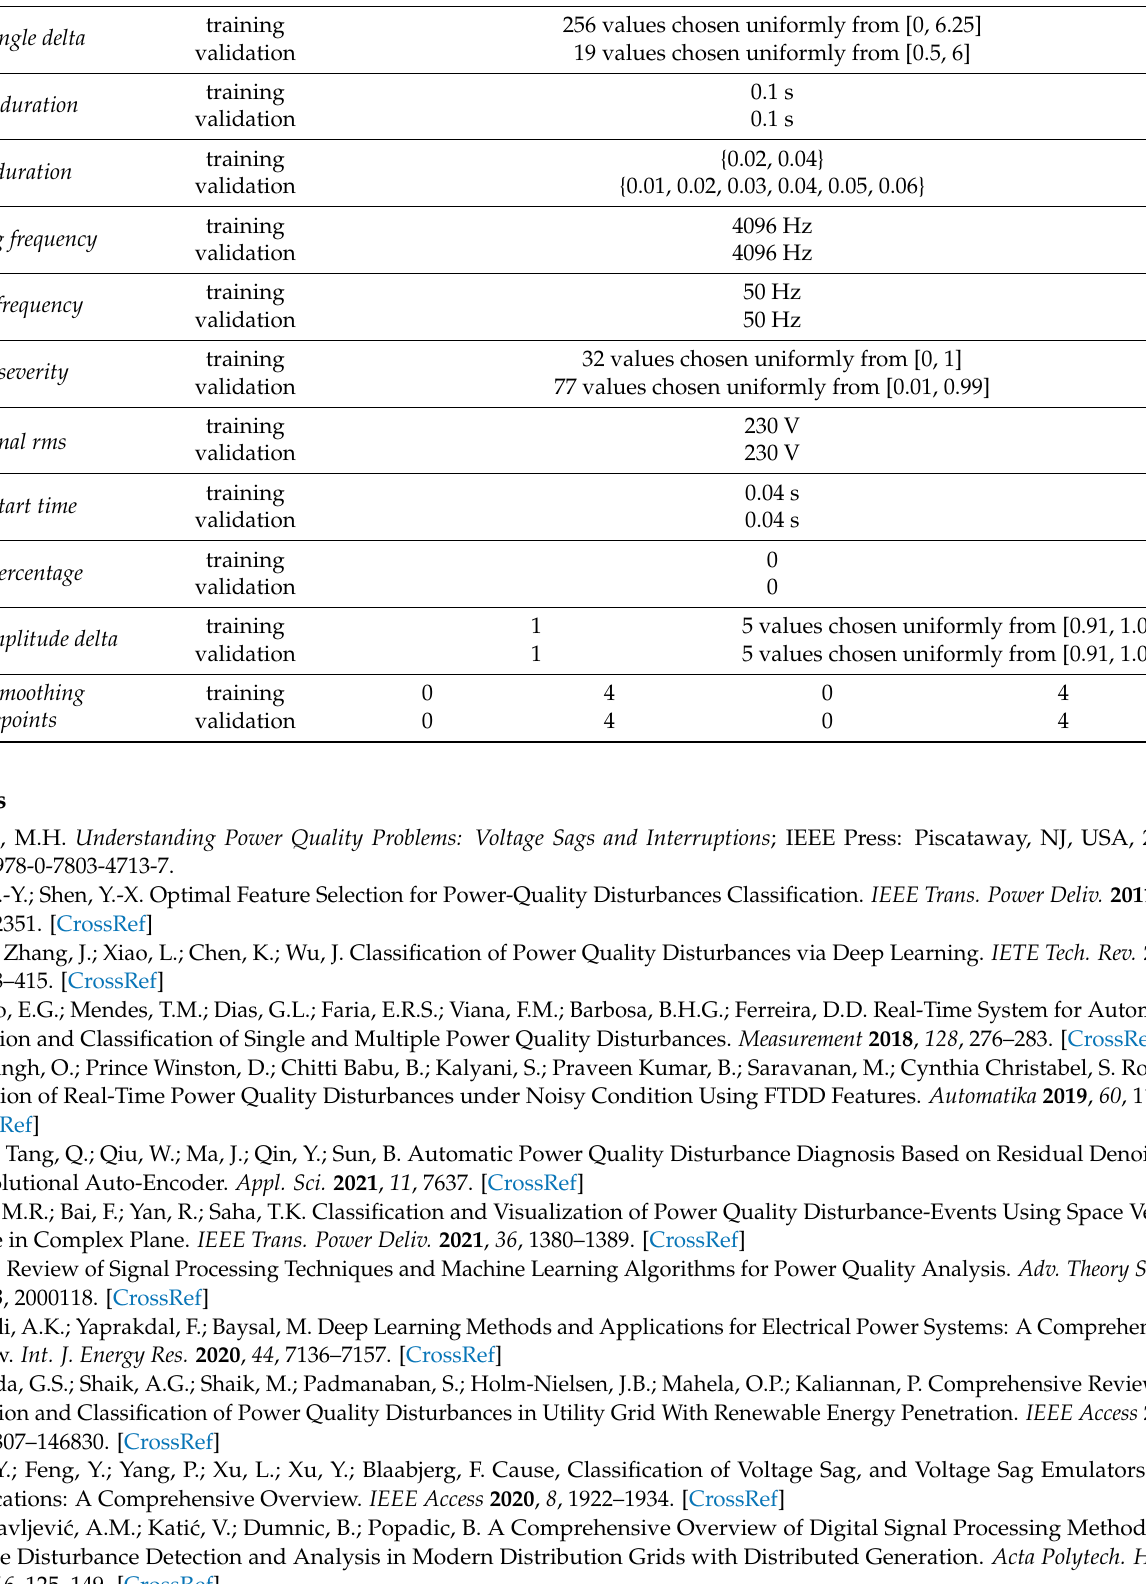
Table A2. List of all values used during generation for each of the sets, subsets, and parameters. Parameter Subset Sterile Smooth Varied_Normal